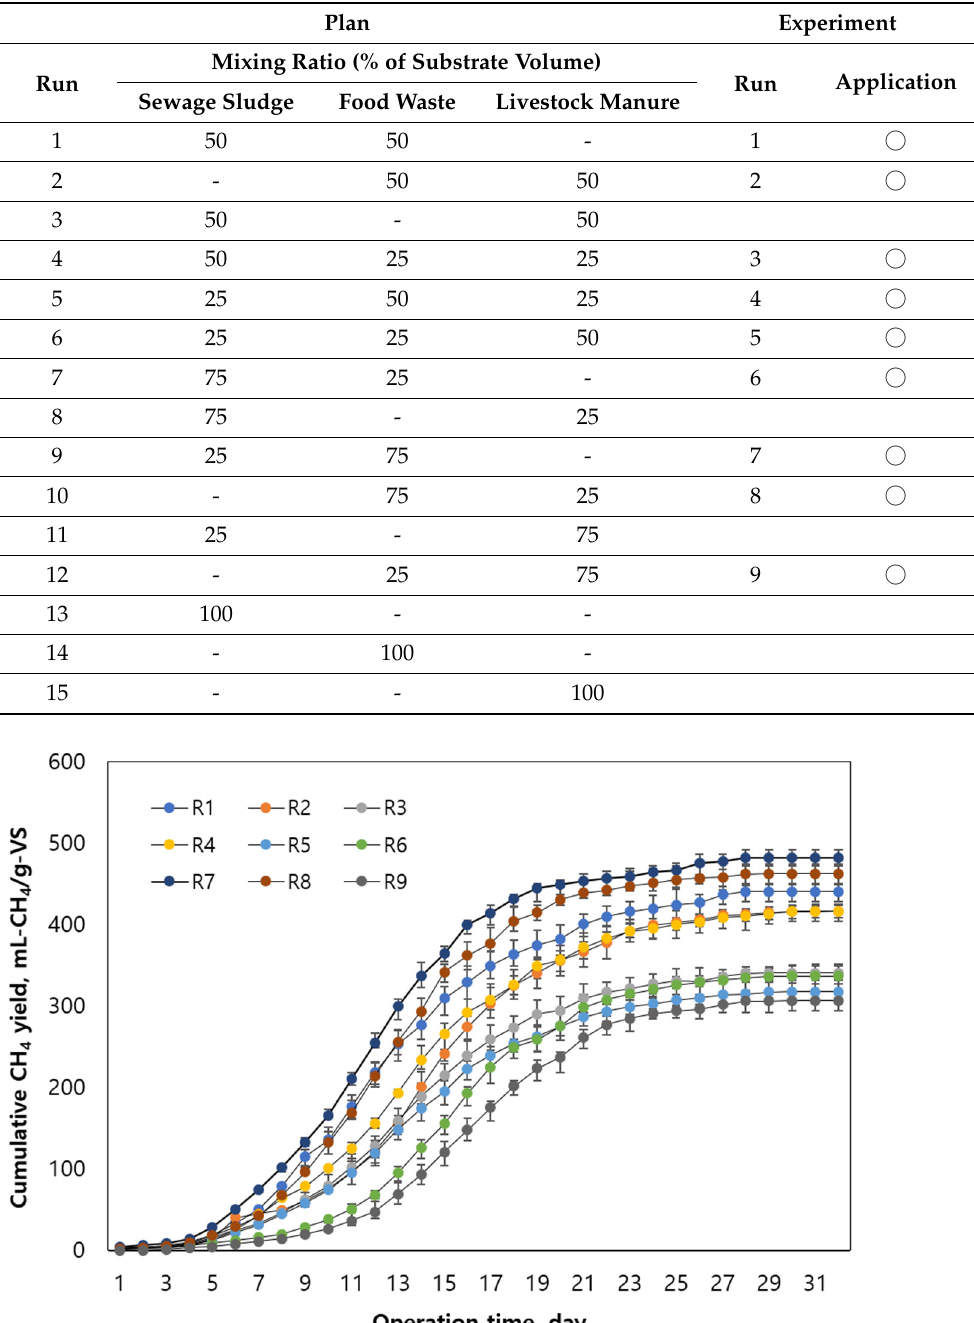
Table 5. Classification and regression mixing ratios according to trees.